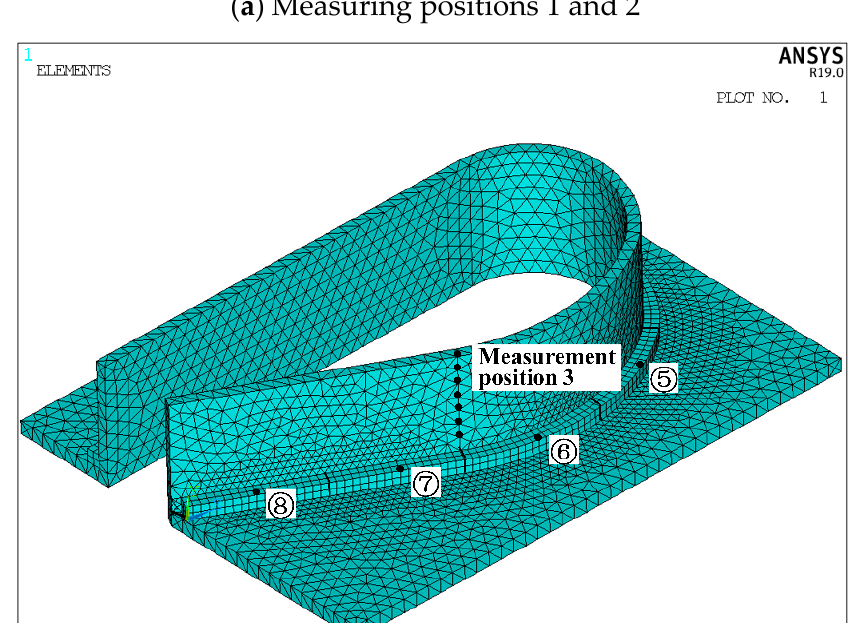
Figure 14. Schematic diagram of measurement positions.